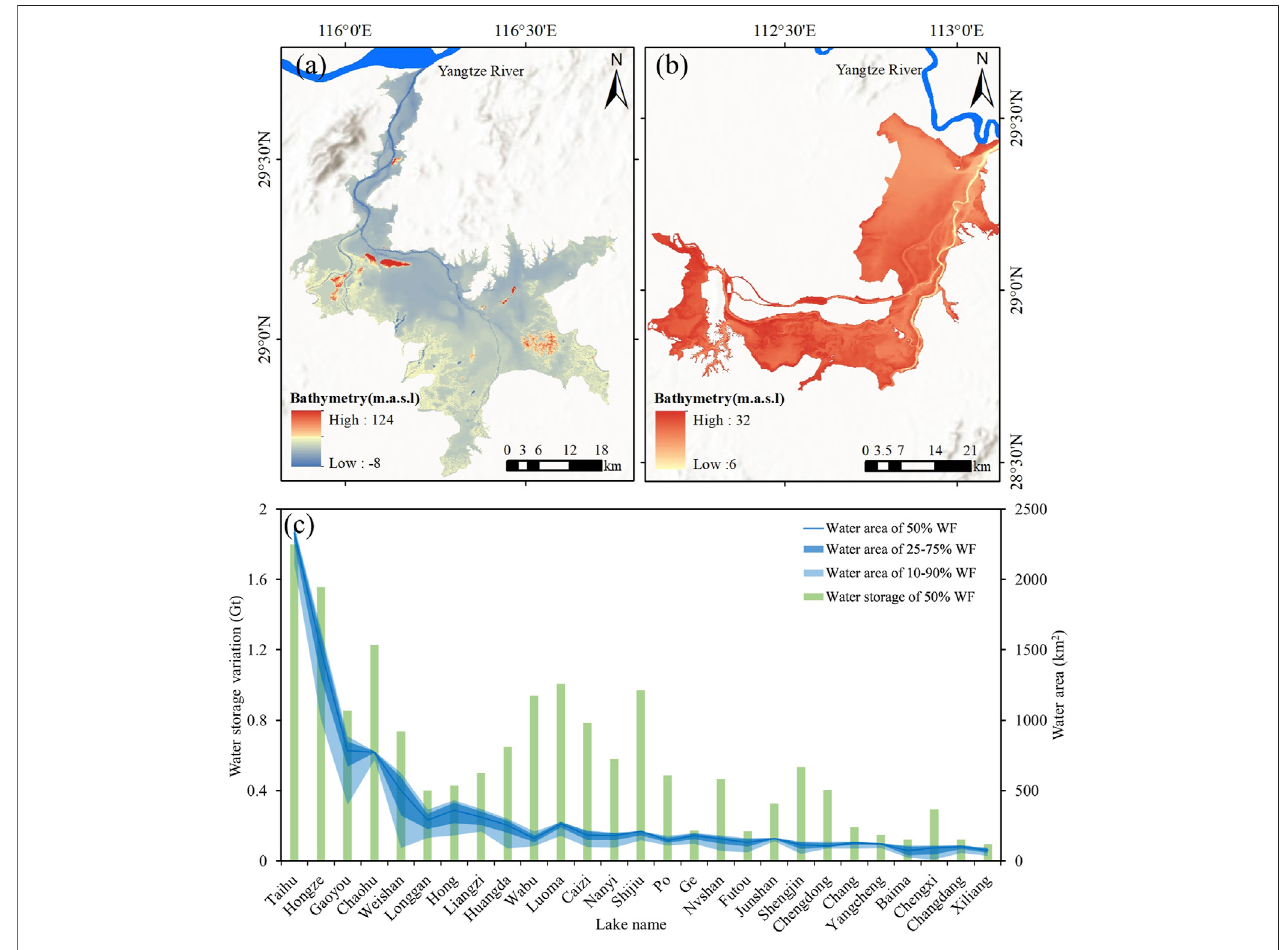
FIGURE4 | The seasonal amplitude ofwater storage variations forthe plain lakegroup. (A) Bathymetry ofPoyang Lake; (B) Bathymetry ofDongting Lake; and (C) The seasonal amplitude of water storage variations for 27 lakes (ranking by lake water inundation area, with the exclusion of Poyang and Dongting Lakes).